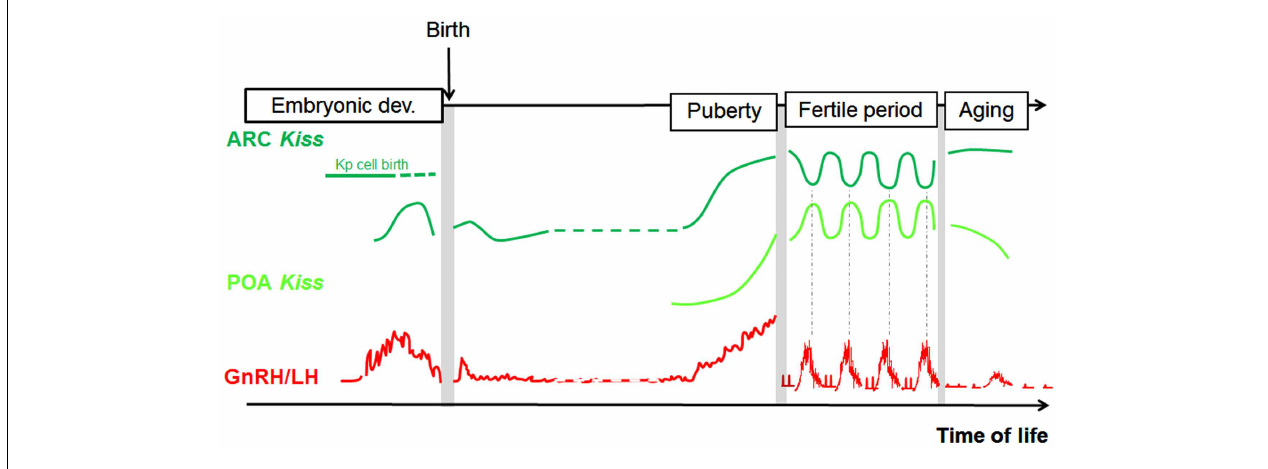
windows of rat development (separated from each other by grey bars on the scheme because analyzed in separate studies). POA, preoptic area; ARC, arcuate nucleus; Kp, kisspeptin; LH, luteinizing